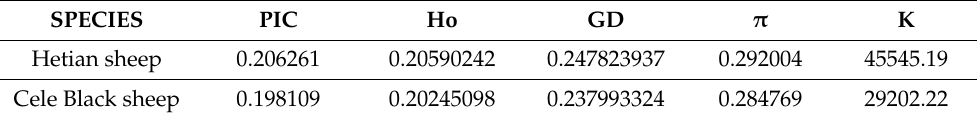
Table 1. Comparison of genetic parameters between Hetian and Cele Black sheep population groups. SPECIES PIC Ho GD π K Hetian sheep 0.206261 0.20590242 0.247823937 0.292004 45545.19 Cele Black sheep 0.198109 0.20245098 0.237993324 0.284769